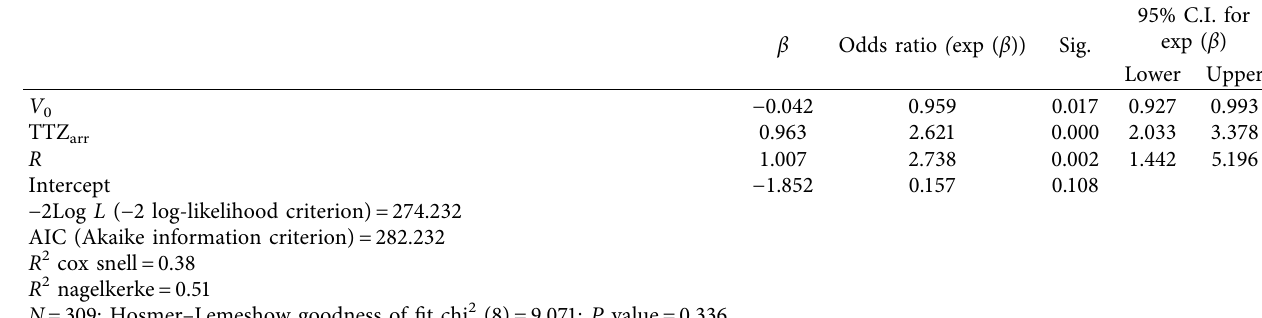
Table 3: Binomial logit model.